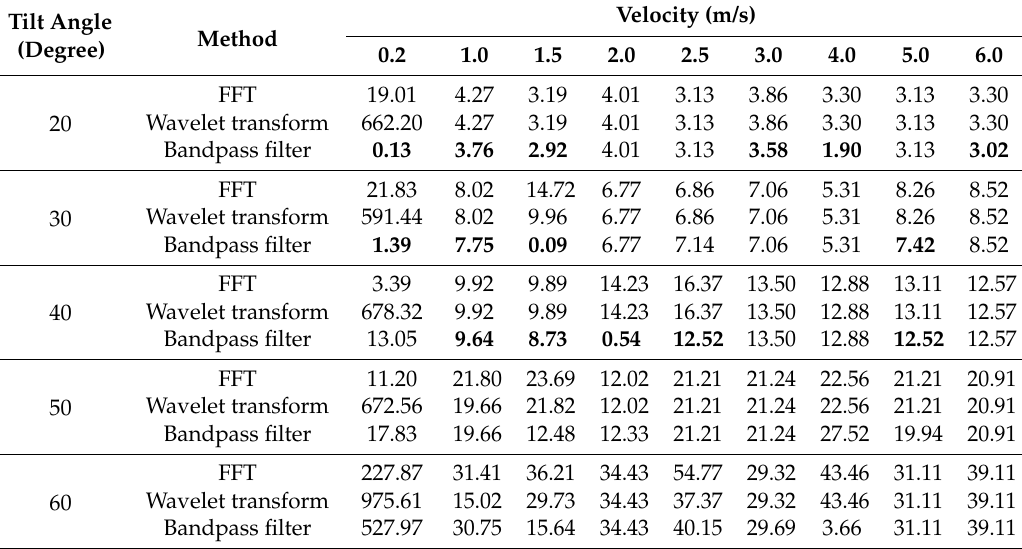
Table 2. Comparison of the relative identification errors under different tilt angles and movement speeds of the trolley (Note that the values in bold indicated the lowest relative error when the tilt angle ranged between 20 and 40